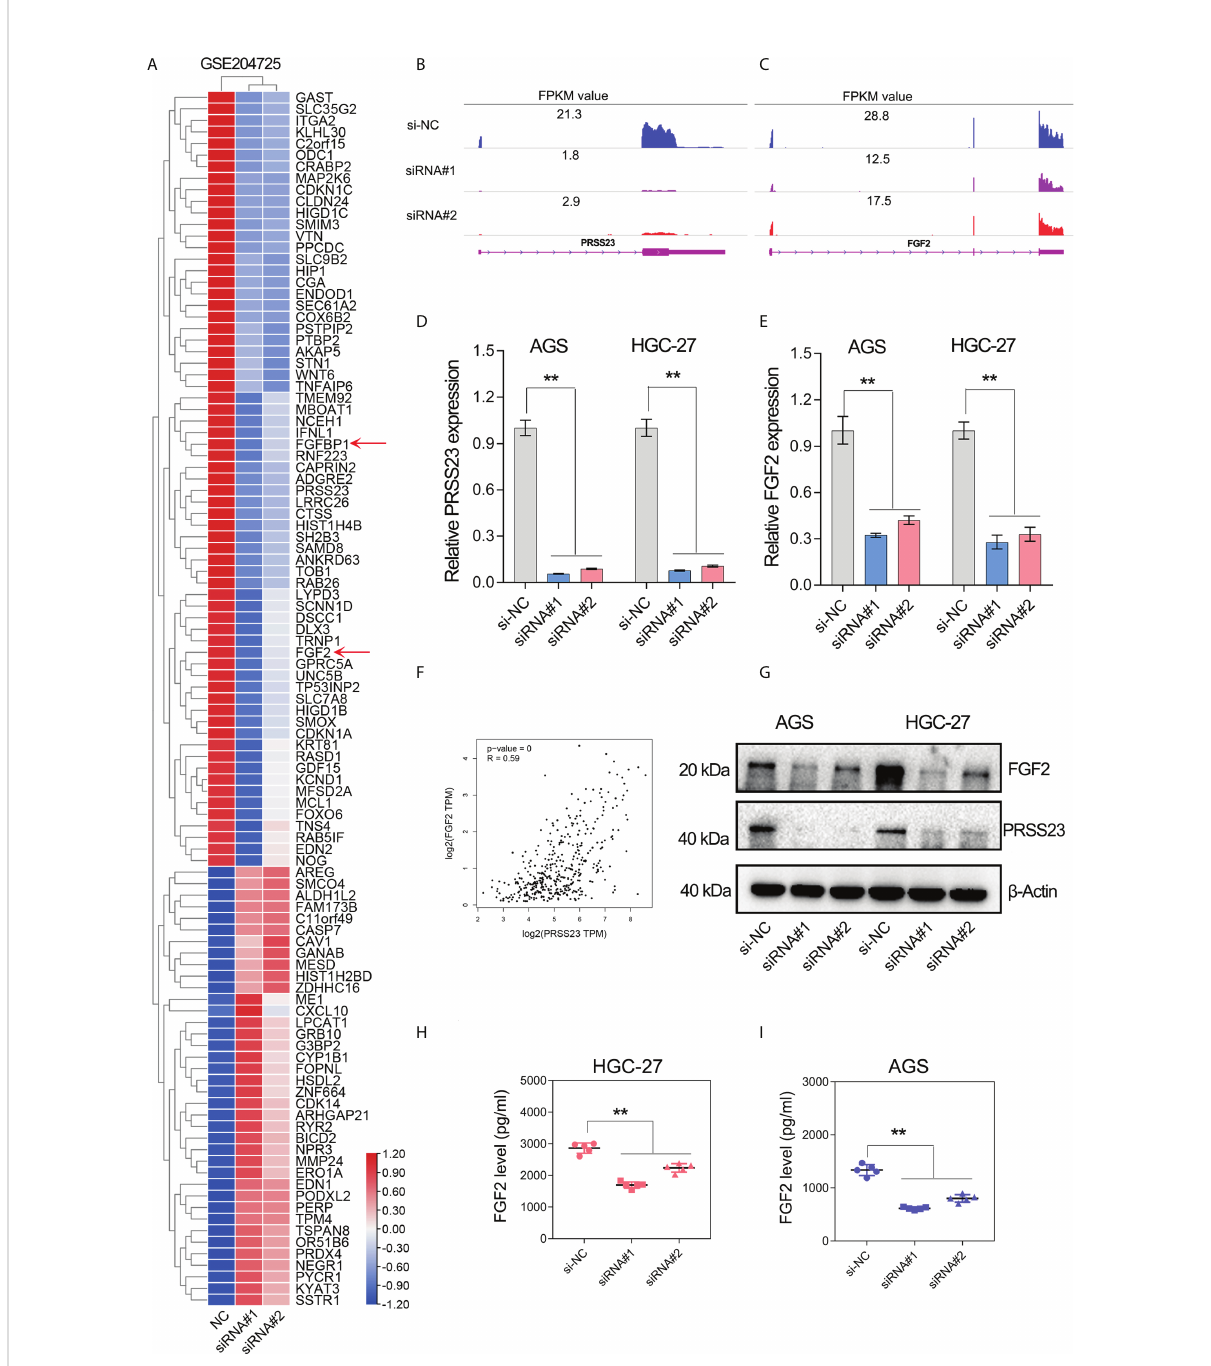
FIGURE 5 PRSS23 knockdown decreased FGF2 expression and secretion in GC. (A) RNA-seq studies were conducted in GC cells transfected with siRNAs targeting PRSS23. The most signi fi cantly altered genes upon PRSS23 knockdown were shown in the heatmap. (B, C) The transcripts abundance of PRSS23 and FGF2 in PRSS23-depleted GC cells was detected by RNA-seq. The normalized expression (FPKM value) of PRSS23 and FGF2 were shown in the plot. (D) The knockdown ef fi ciency of PRSS23 in GC cell lines was examined by qRT-PCR assay. (E) The effect of PRSS23 knockdown on FGF2 expression in GC cell lines were examined by qRT-PCR assay. (F) PRSS23 and FGF2 were highly co-expressed in GC. (G) The effect of PRSS23 knockdown on FGF2 protein level in GC cell lines were examined by western blotting assay. ( H, I ) ELISA assay showed that PRSS23 knockdown signi fi cantly decreased secreted FGF2 level in GC cell lines. **, P <